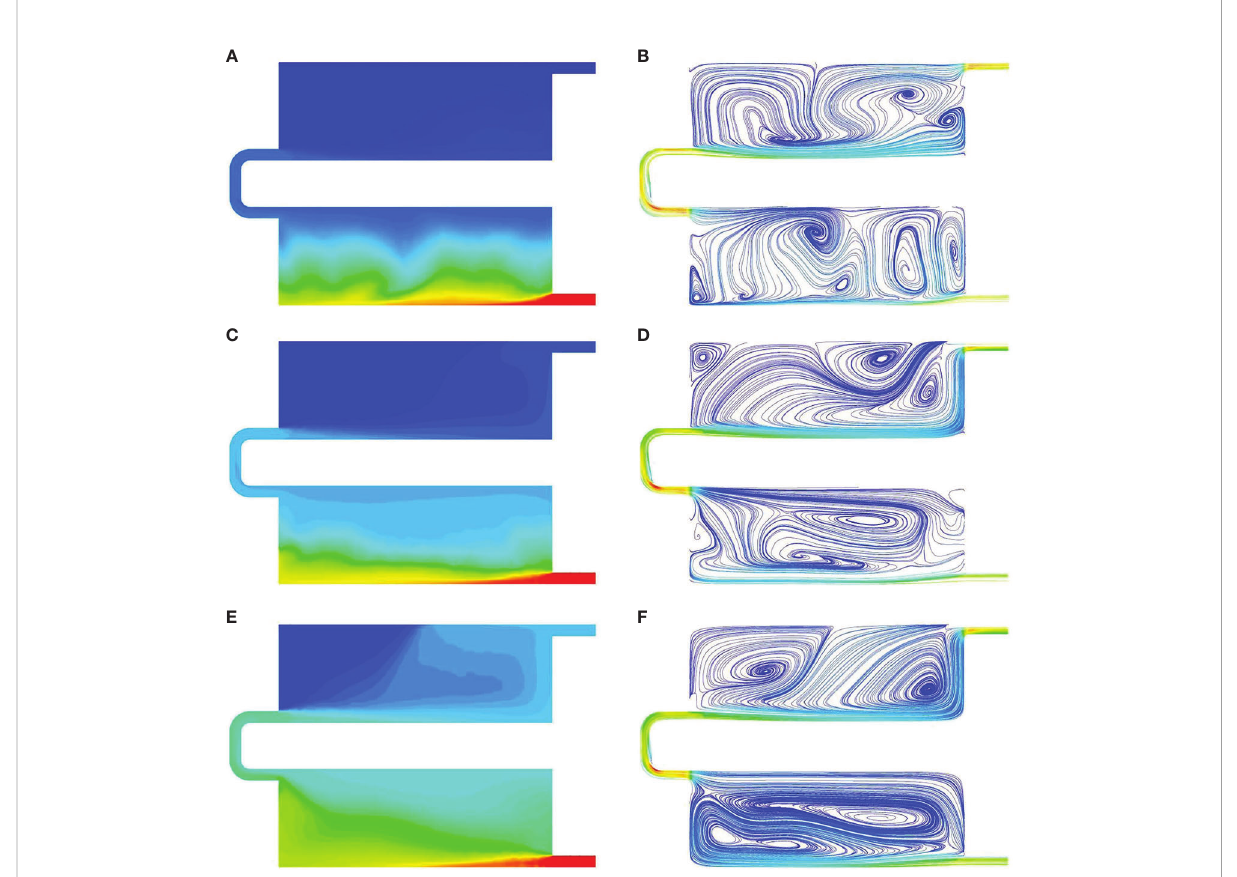
FIGURE 8 Density strati fi cation and velocity distribution, (A) Density strati fi cation at 0.044m/s, (B) Velocity distribution at 0.044m/s, (C) Density strati fi cation at 0.1m/s, (D) Velocity distribution at 0.1m/s, (E) Density strati fi cation at 0.2m/s, (F) Velocity distribution at